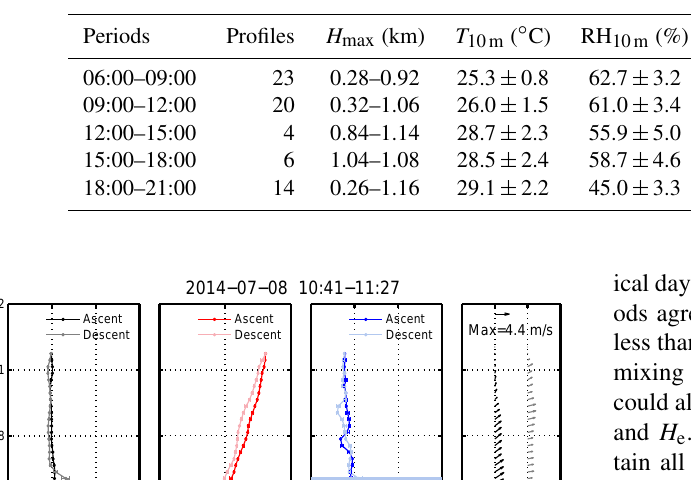
Table 1. A statistical summary of the field campaign and the meteorology. H max denotes the maximum height reached by the tethered balloon. T 10m , RH 10m , and WS 10m indicated temperature, relative humidity, and wind speed within 10m near the surface, in the form of average value ± standard deviation. WD 10m represents frequently encountered wind direction. The last column gives the weather that mostly occurred during each period.